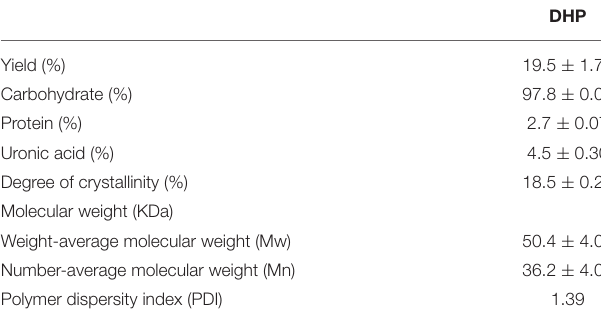
TABLE 2 | Physicochemical properties of